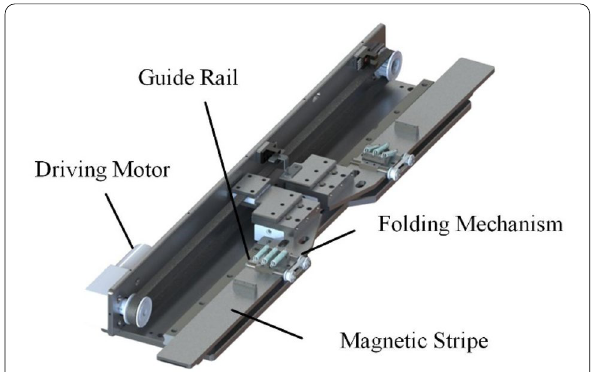
Figure 6 Structure of the stripe expansion device